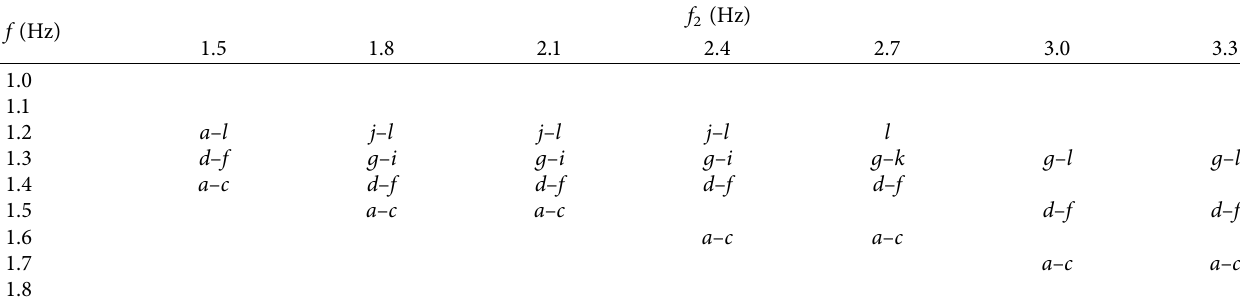
Table 6: The peak of structural dynamic response corresponding to swaying